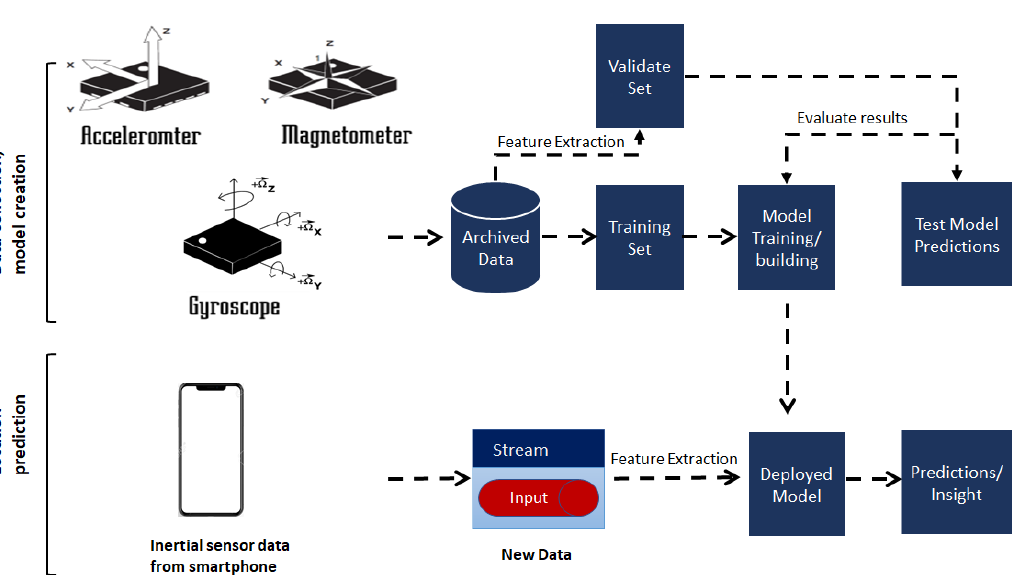
10 of 18 Table 1. The experimental model with the hyperparameter values. Parameter